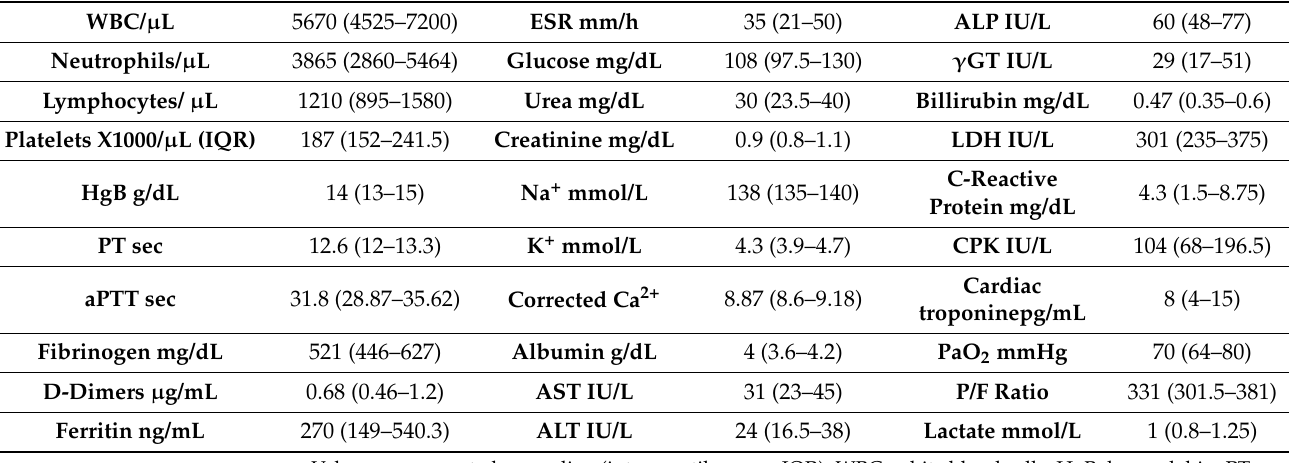
Table 3. Laboratory values on admission.